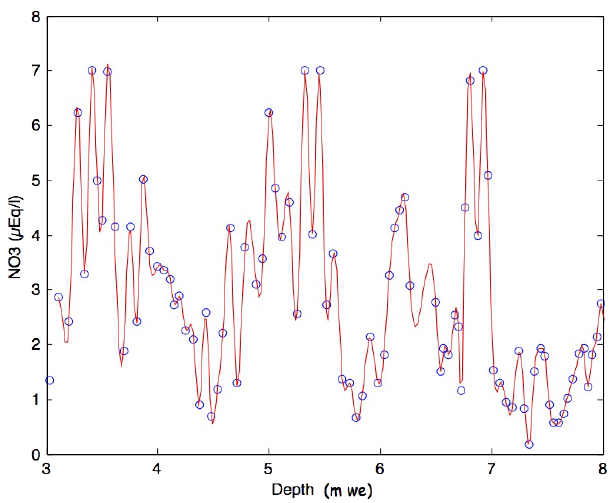
(d) raw signal (circles) and the spline interpolation Figure 3. c NO − 3 (red line).